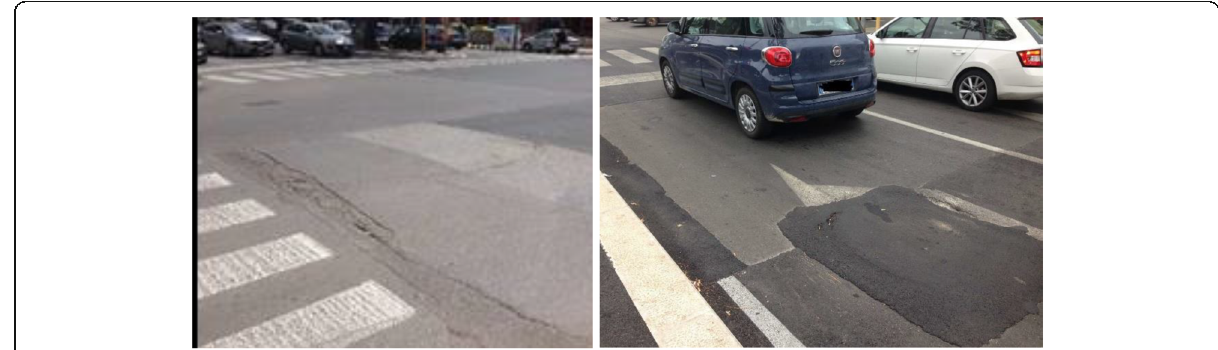
Fig. 3 Example of pavement conditions considered as “ poor ” conditions (i.e., with cracks, deformations, or potholes on the left; with irregular surface on the right